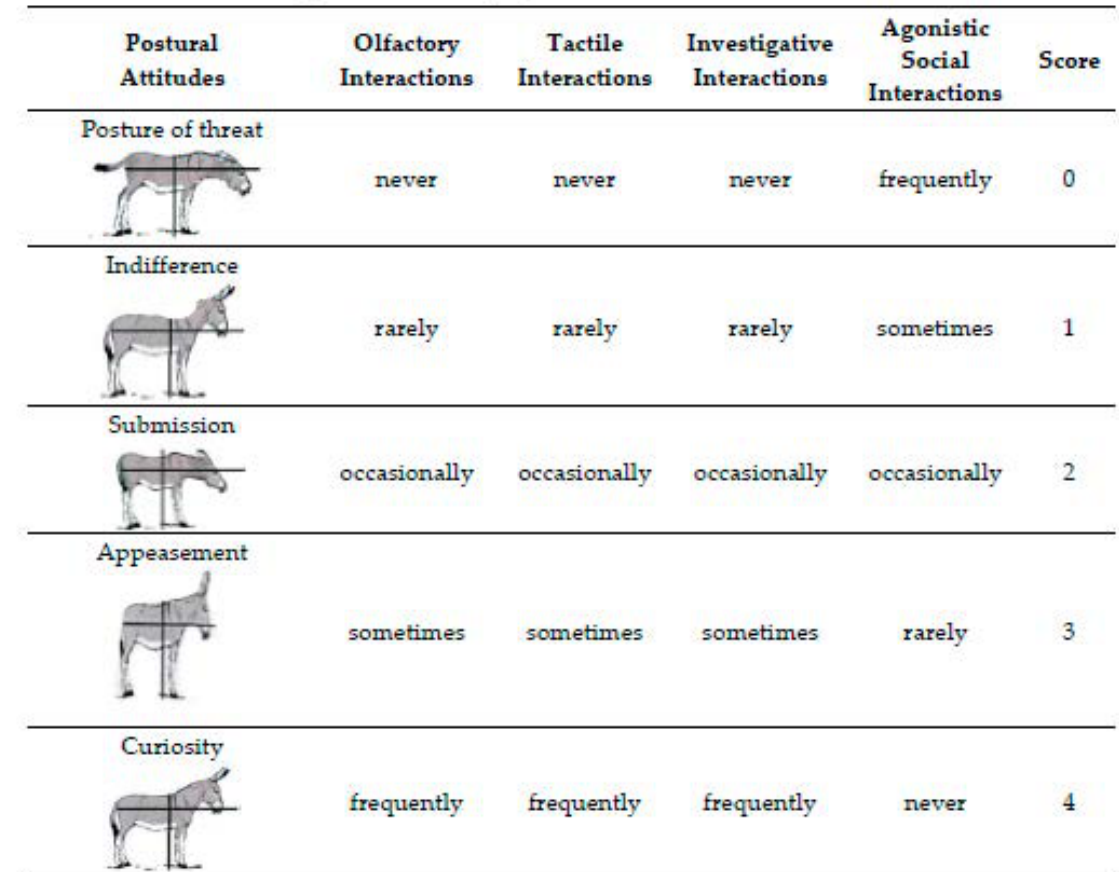
Figure 2. Qualitative judgment of binomial human-animal.